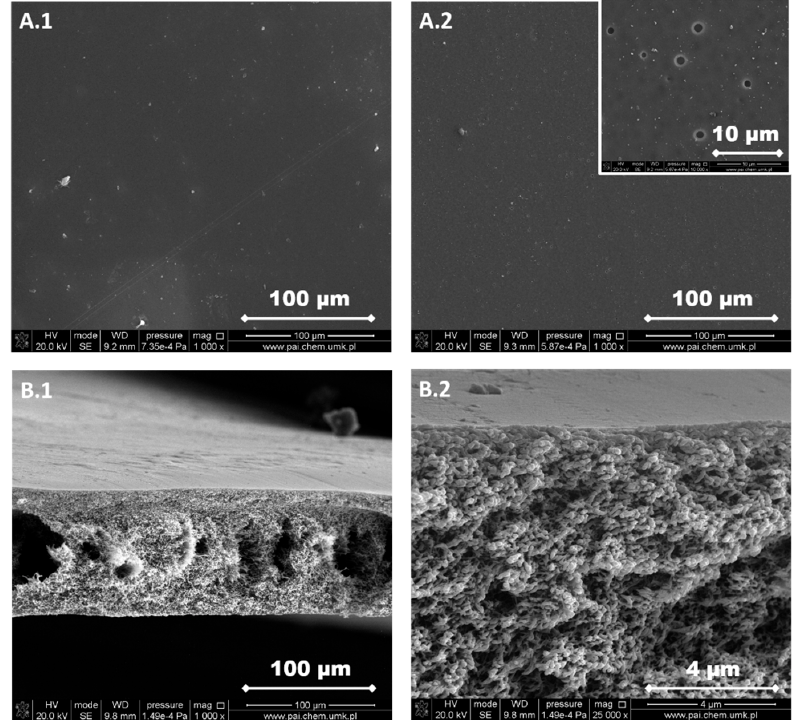
Figure 5. SEM images of M3 membrane. ( A.1 ) Selective layer, ( A.2 ) support layer, ( B.1 ) a cross-section of the membrane, and ( B.2 ) a cross-section of the membrane at higher magnification.